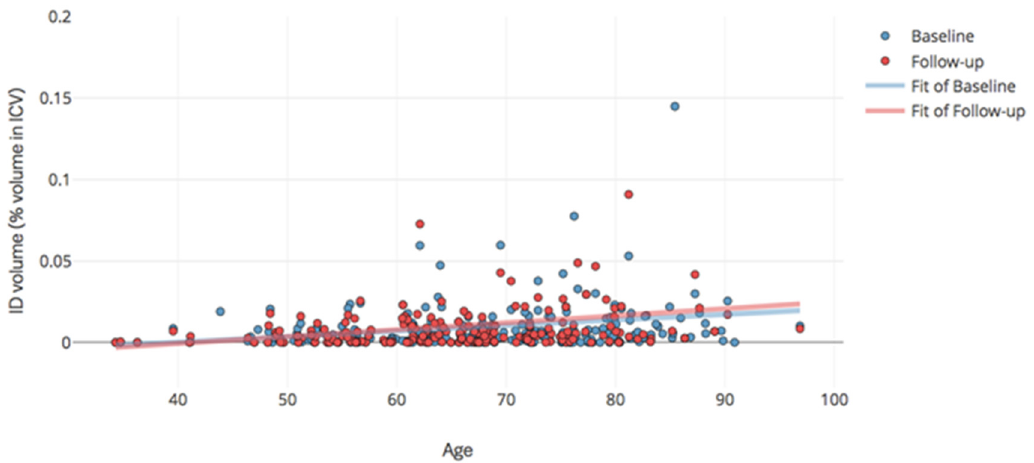
Figure 2. Correlation between age and volume of striatal iron deposition at both: baseline (blue) and follow-up (red).